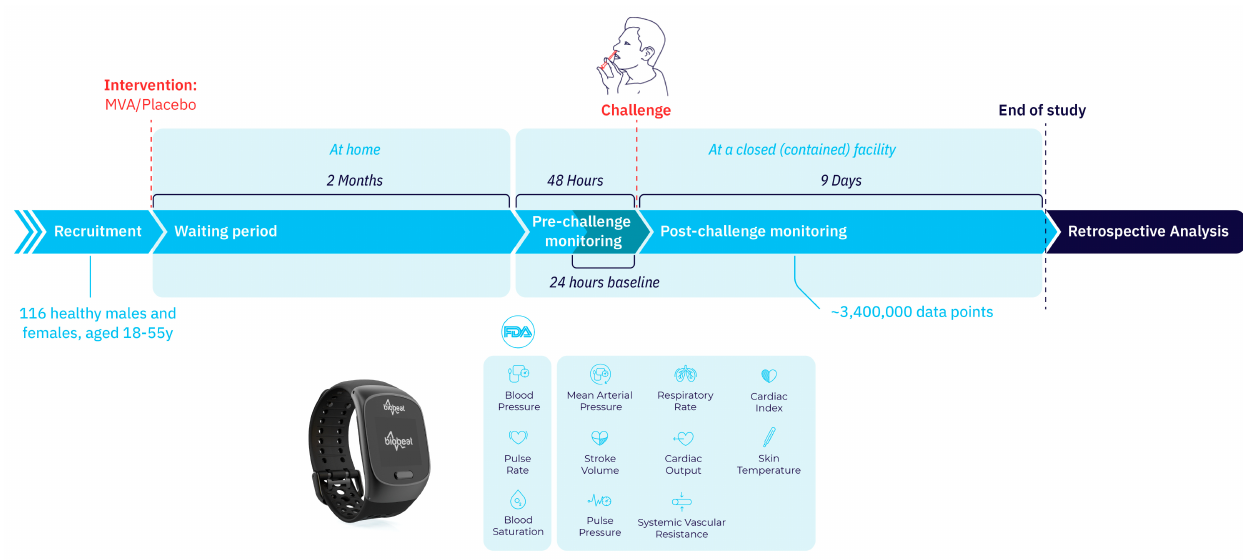
Figure 2. Study design. A total of 116 healthy individuals were recruited. Two months following randomization and treatment with vaccine or placebo, they were admitted into a confined facility in which they were continuously monitored using an FDA-cleared wireless remote patient monitoring device. 48 h after admission all were intranasally exposed to H3N2 influenza virus, monitoring continued for 9 more days, and daily surveys were completed twice a day during the whole 11 days. The physiological parameters were collected automatically with no personally identifiable information and analyzed retrospectively following study